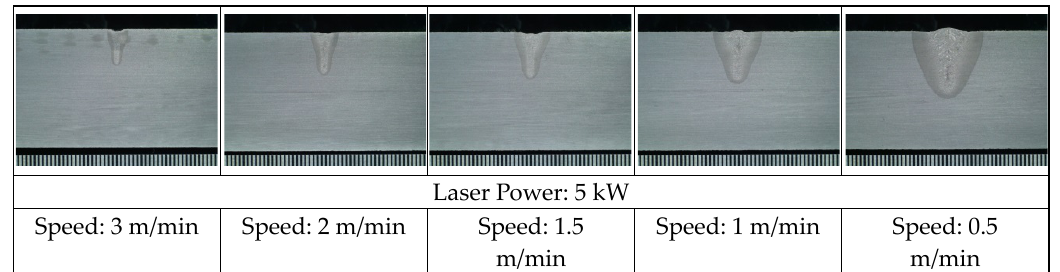
Figure 7. Bead geometry on BOP welding test (laser power: 5 kW).